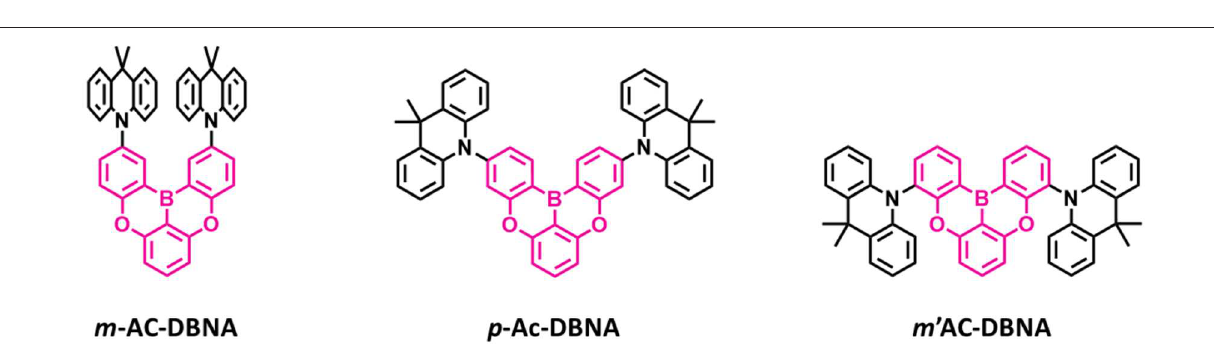
FIGURE 8 | Reported structures of blue thermally activated delayed fluorescence (TADF) emitters using donor units attached to the different positions of the boron-based